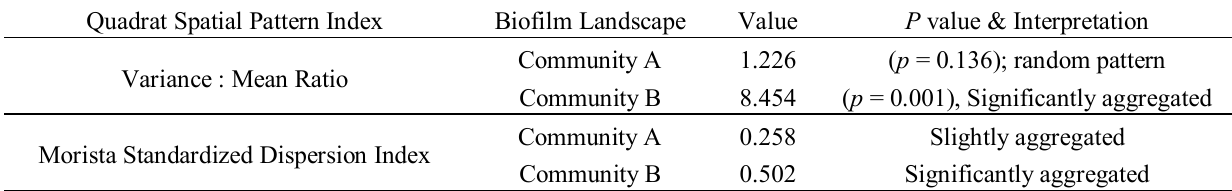
Table 8. Plot-based quadrat-lattice spatial pattern analysis of biofilm communities A and